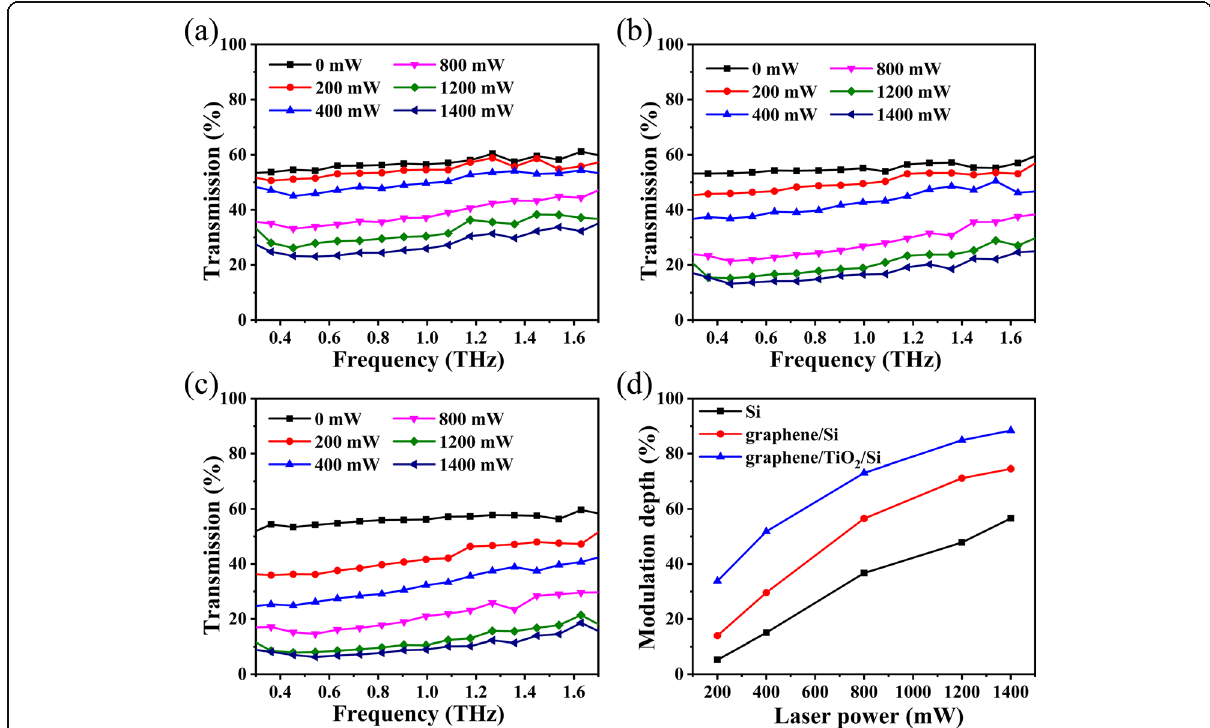
Fig. 2 The modulation test. The transmittance spectra of the a Si, b graphene/p-Si, and c graphene/TiO 2 /p-Si at different laser power. d The modulation depth as functions of laser power for Si, graphene/Si, and graphene/TiO 2 /p-Si